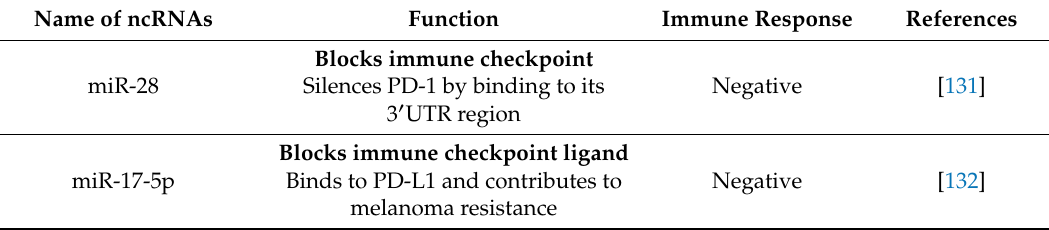
Table 2. Non-coding RNAs that interfere with immunotherapy in a negative or positive